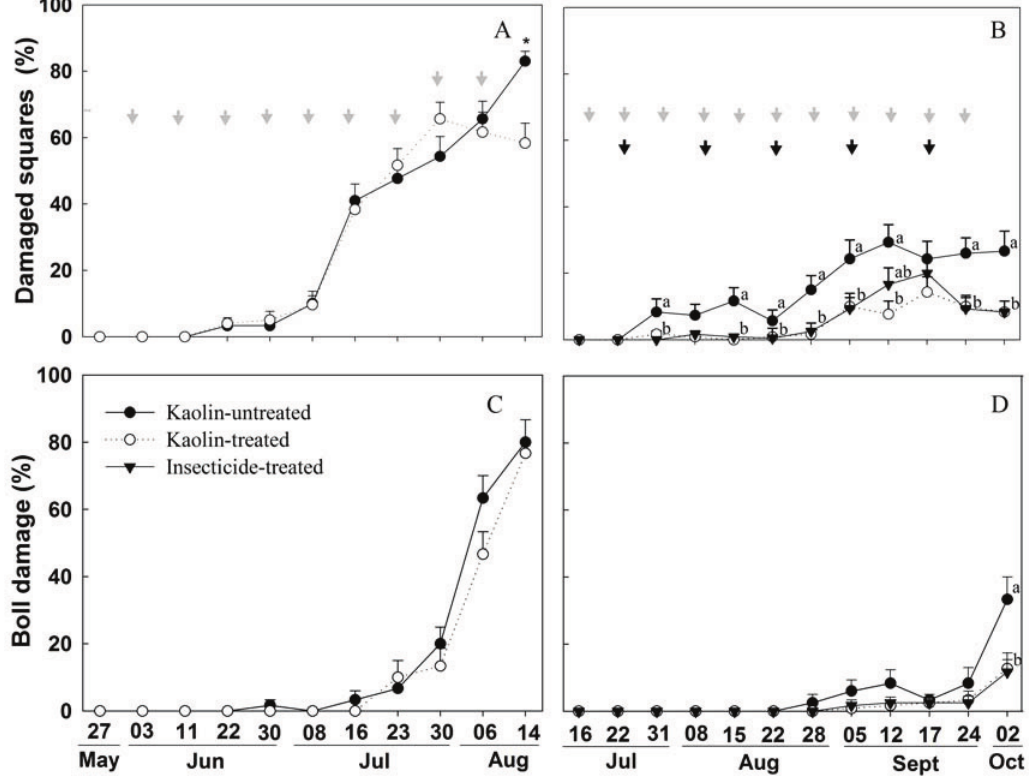
Figure 2. Mean of square and boll damage by boll weevils in kaolin-treated and kaolin-untreated plots during the 2010 season ( A and C ), and in kaolin-treated, untreated and insecticide-treated plots during the 2011 season ( B and D ). Gray and black arrows indicate kaolin and insecticide applications, respectively. Means (+SE) with different letters for the same date are statistically different at the 0.05 significance level (Tukey HSD’s